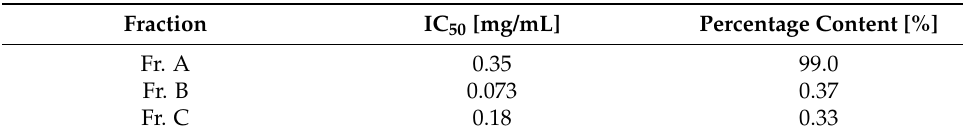
Figure 3. TSKgel ODS-120T filtration chromatogram of the <3 kDa fraction of L. casei 001-fermented Hidakakombu. Chromatogram shows three fractions (Fr. A–Fr. C). Table 2. IC 50 (Angiotensin-converting enzyme inhibitory activity) and percentage of each fraction isolated by TSKgel ODS-120T.